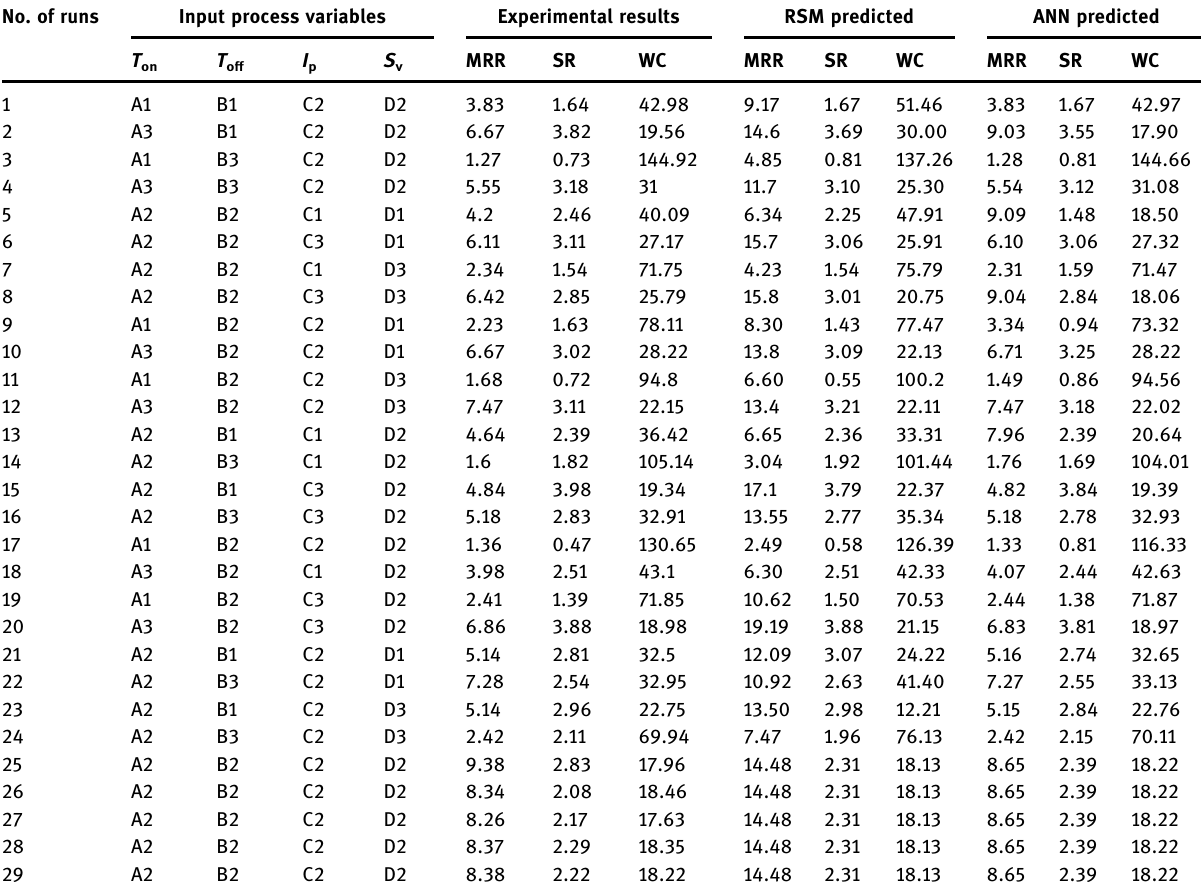
Table 2: Experimental runs No. of